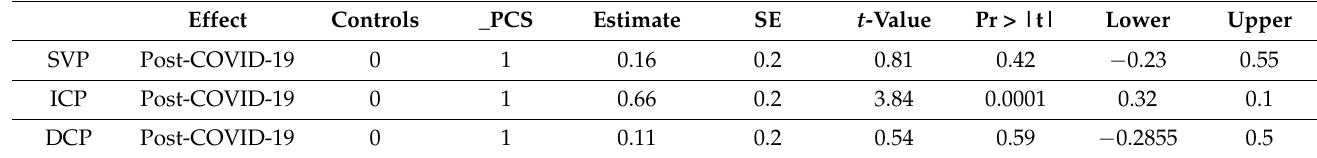
Table 1. Differences in least square means of vessel densities in the SVP, ICP and DCP in patients with post ‐ COVID ‐ 19 syndrome (PCS, 1) compared to controls. SVP—superficial vascular plexus,